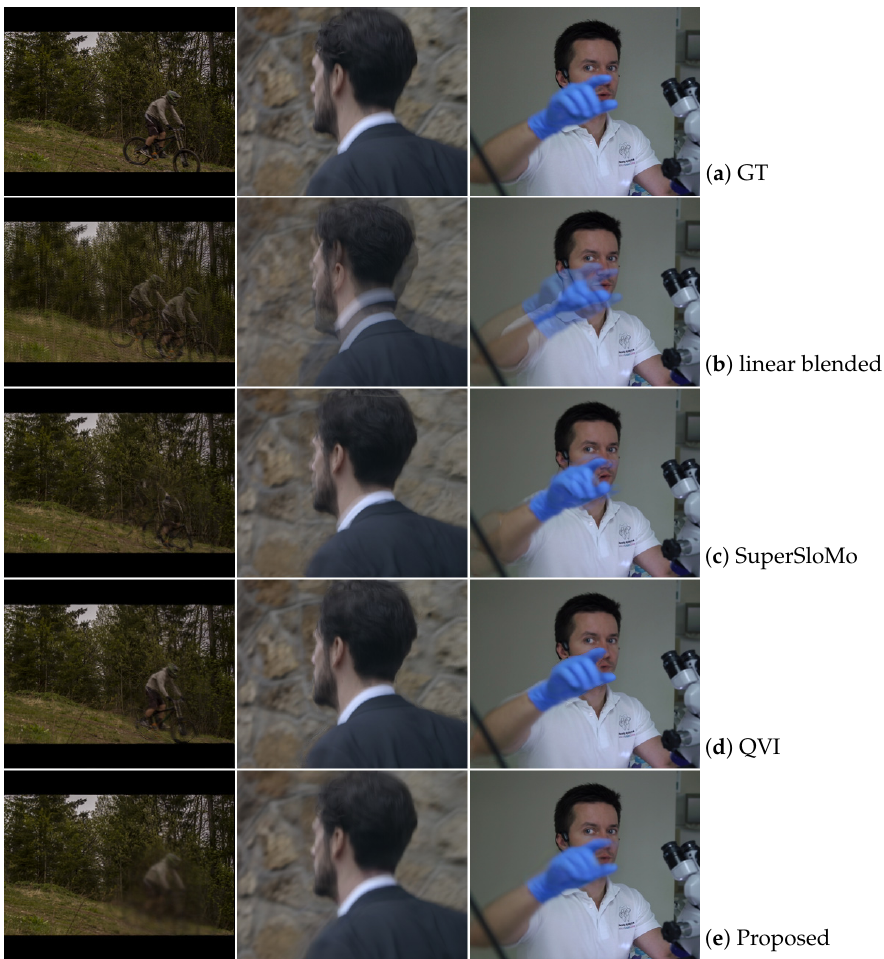
Figure 8. Evaluation of subjective image quality performance on the Vimeo90k dataset of the proposed